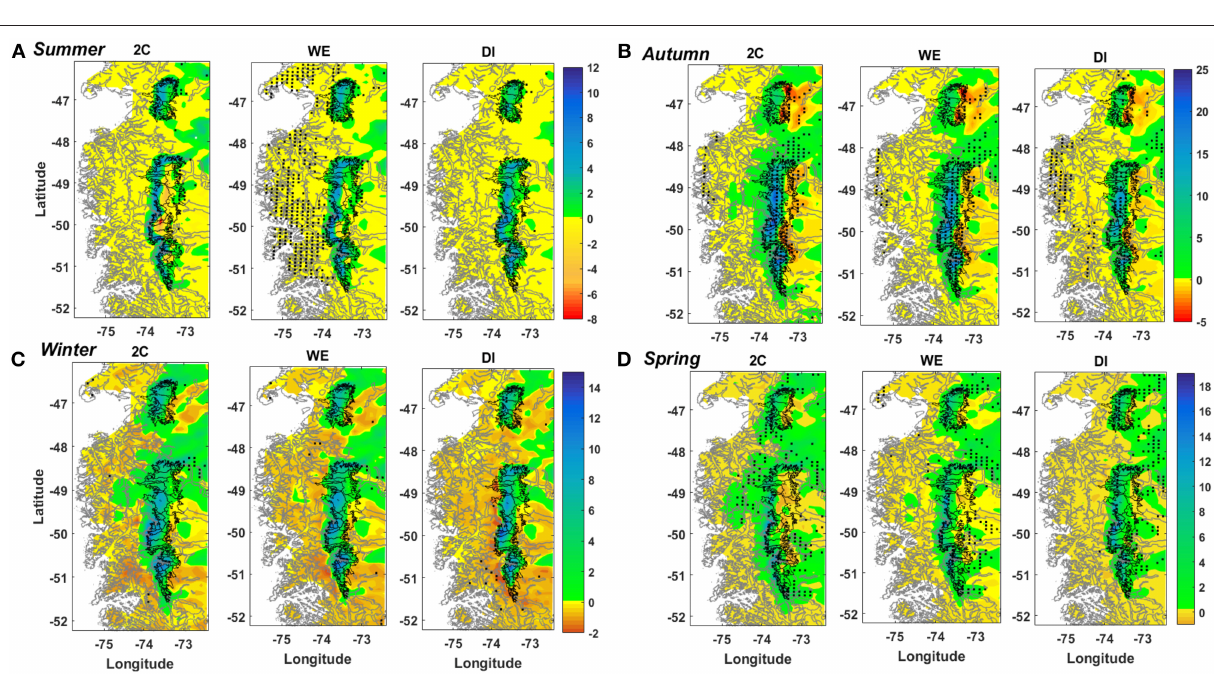
FIGURE 5 | Seasonal trends 1980 − 2015 in mm w.e. yr − 1 for three Phase Partitioning Methods. Points indicate statistically significant trend ( p < 0.05). (A) Summer, (B) Autumn, (C) Winter and, (D) Spring. Icefield contours are in black and coastlines in